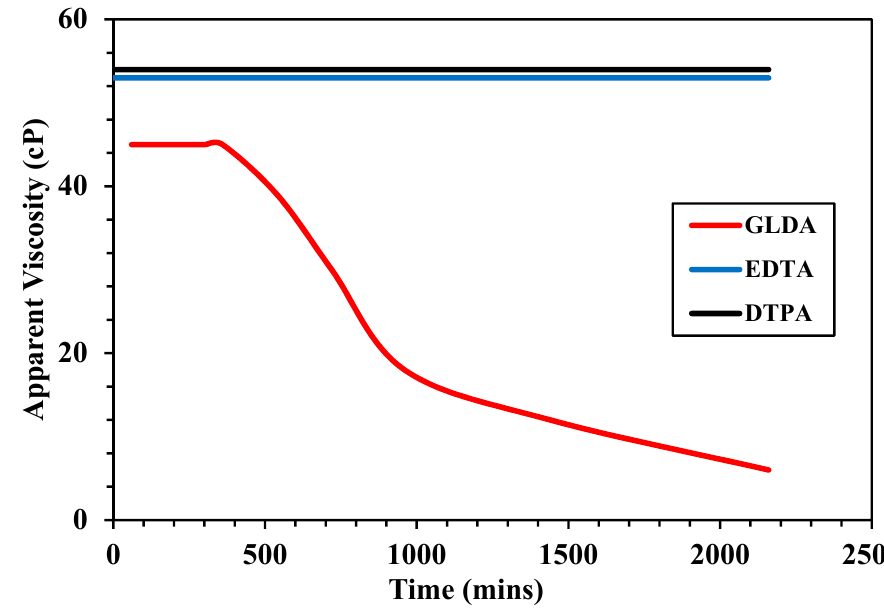
Figure 4. Apparent viscosity of xanthan gum (0.43 wt %) with three different chelating agents (20 wt %) in deionized water (Shear rate- 170.3 s − 1 , T = 200 °F, P = 300 psi, pH = 12).